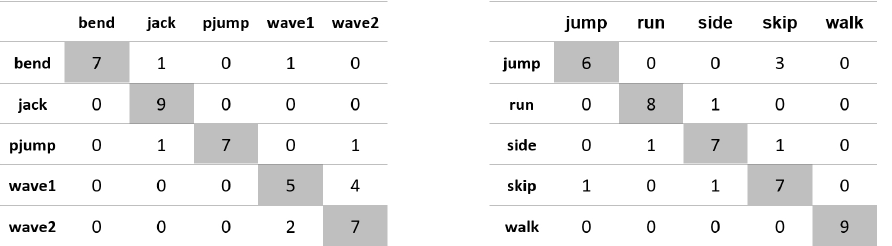
Figure A19. Confusion matrices for the experiment using the ‘upper-occlusion’ database, rectangu- larity and Euclidean